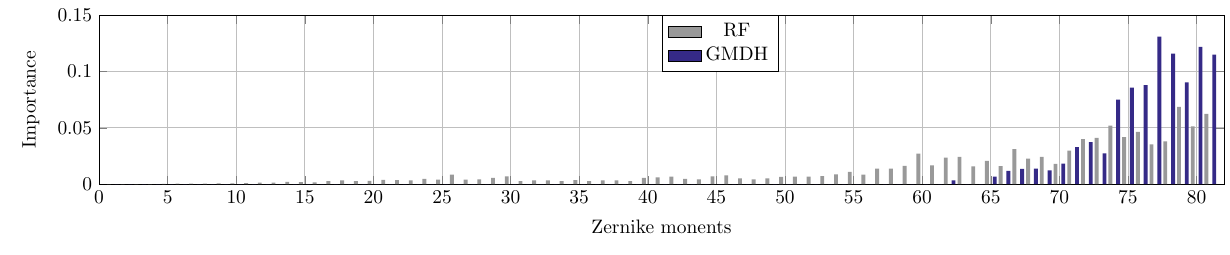
Figure 1. Importance of Zernike moments for the RF and proposed GMDH-type